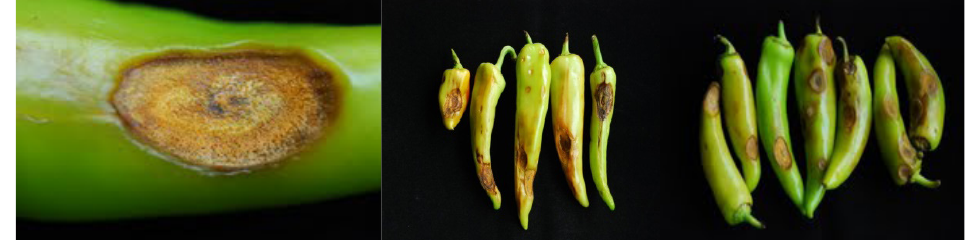
Figure 1: Chili pepper samples with anthracnose symptoms, collected from the local markets of the study